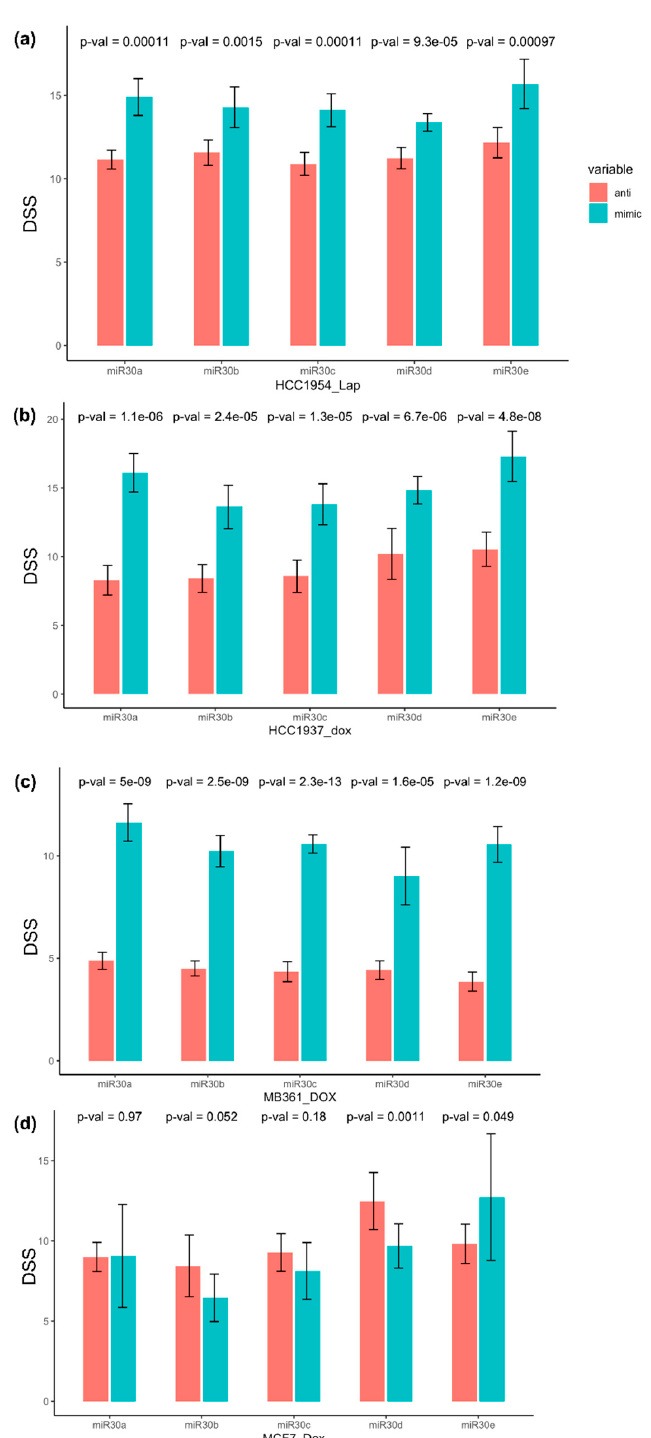
Figure 4. First round of drug screening test: compared to their inhibitors (red/left bars), miR-30 family member-specific mimics (blue/right bars) sensitized breast cancer cell line ( a ) HCC1954 to lapatinib, and ( b ) HCC1937, ( c ) MDA-MB-361, and ( d ) MCF7 to doxorubicin. Higher DSS (drug sensitivity score) indicates higher sensitivity to the drug. Lap: Lapatinib, Dox: Doxorubicin.